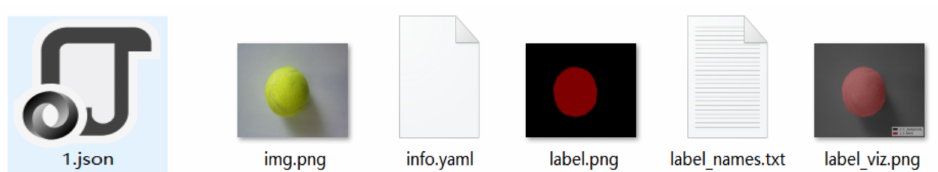
Figure 10. Json files and the description